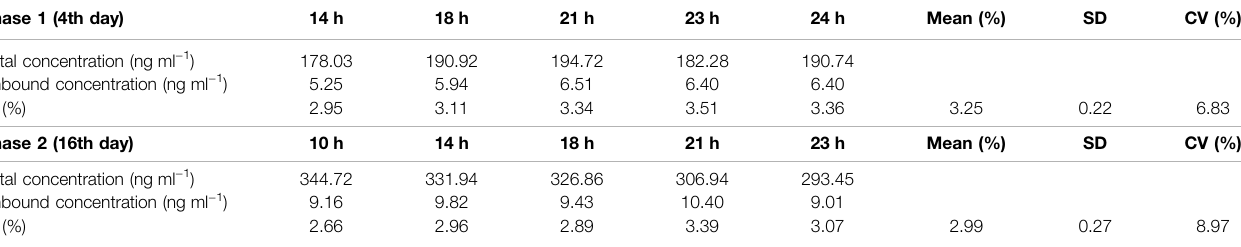
TABLE 4 | Total and unbound concentrations of amphotericin B in plasma and in cerebrospinal fl uid samples. Total plasma concentration (ng ml − 1